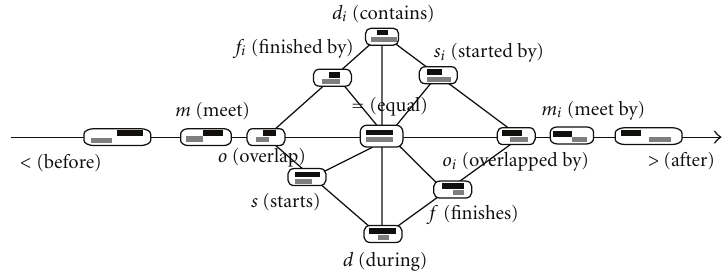
Figure 2: Black segment represents the reference object and gray segment represents argument